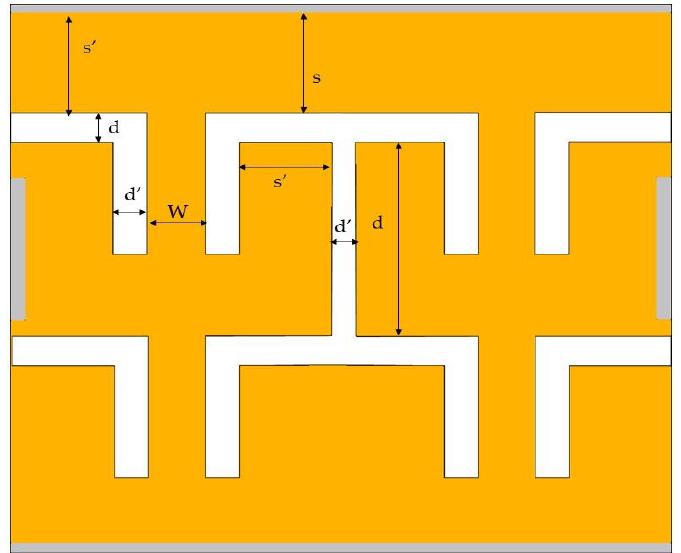
Figure 12. Structural parameters for estimation of channel capacitances, C SSD and trench capacitance, C trench . Table 2. Parameter values for each structural parameter of channel capacitances, C SSD and trench capacitance, C trench .